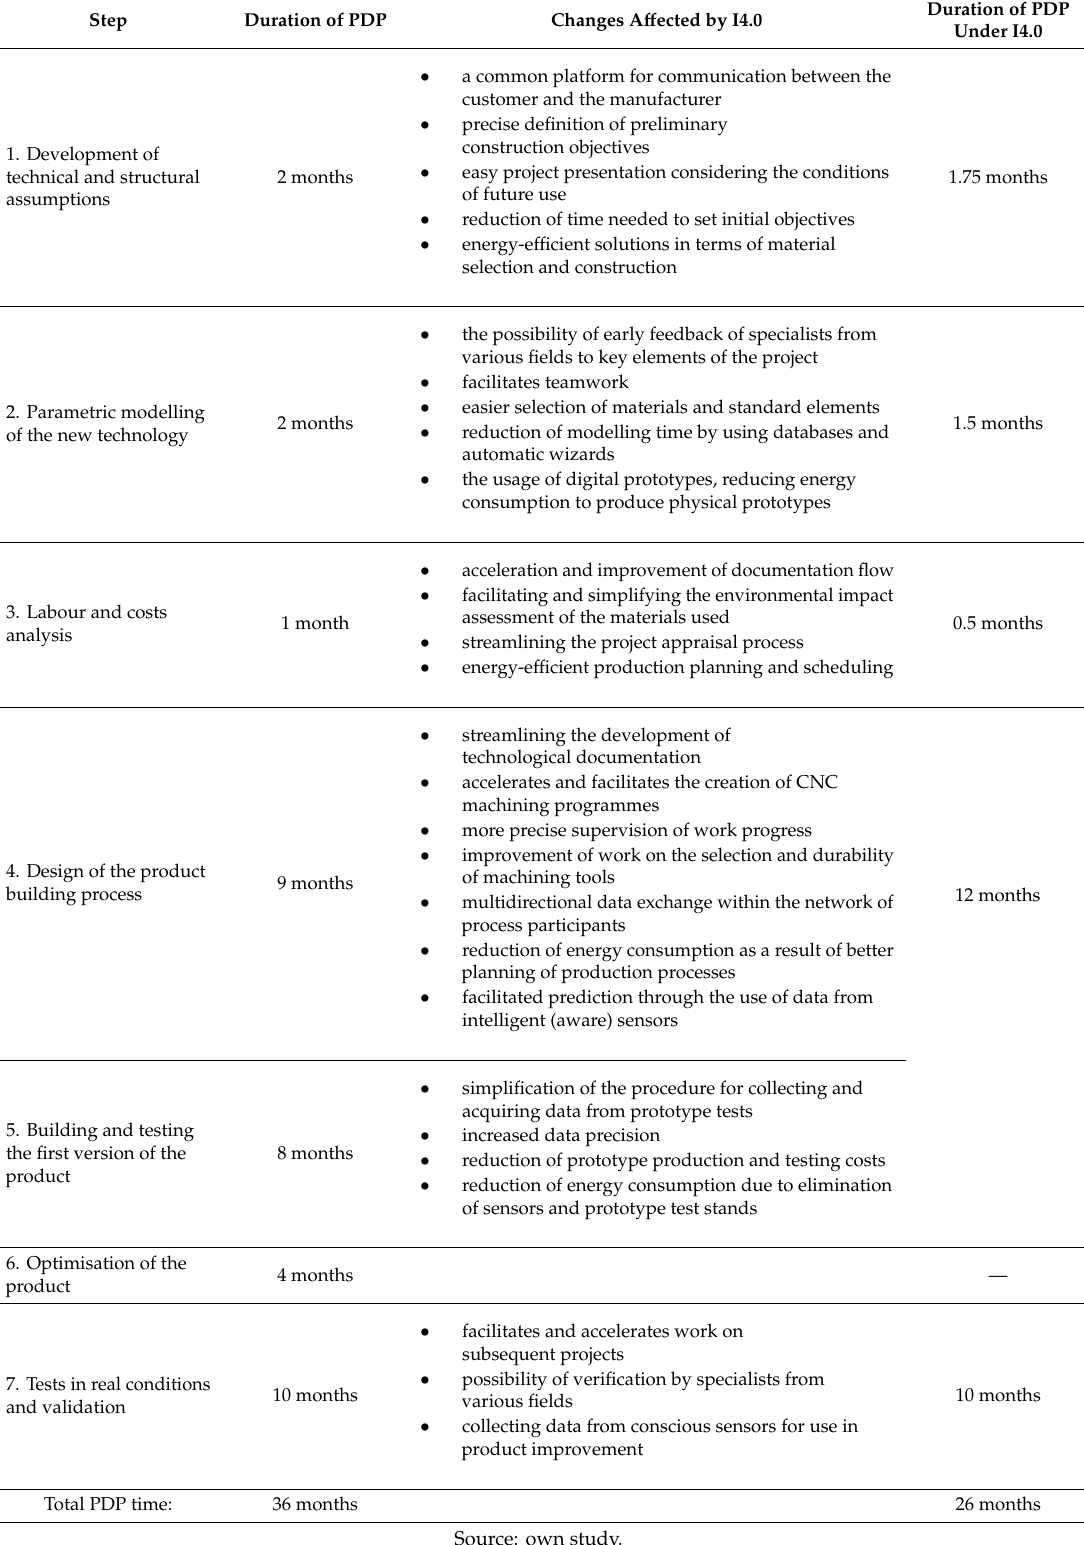
Table 2. Estimated durations of the PDP steps at present and following the introduction of